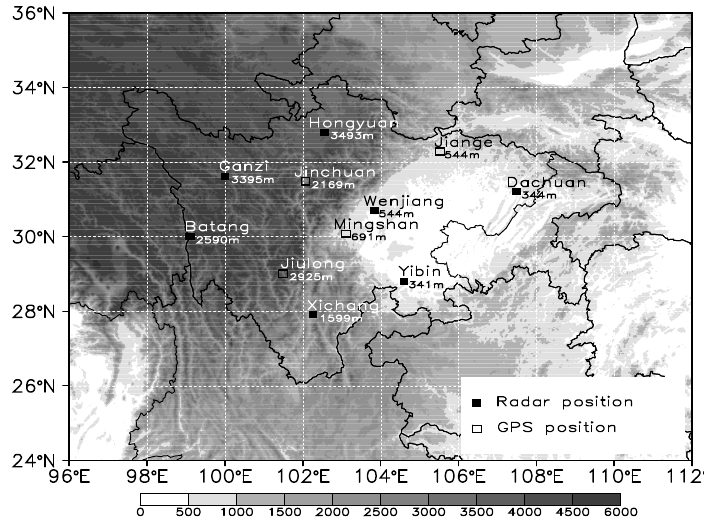
Figure 1. Map plot of terrain elevations over the East and downstream of the Tibetan Plateau, and locations of the radiosonde sites. Heights are in meters above mean sea level (MSL).